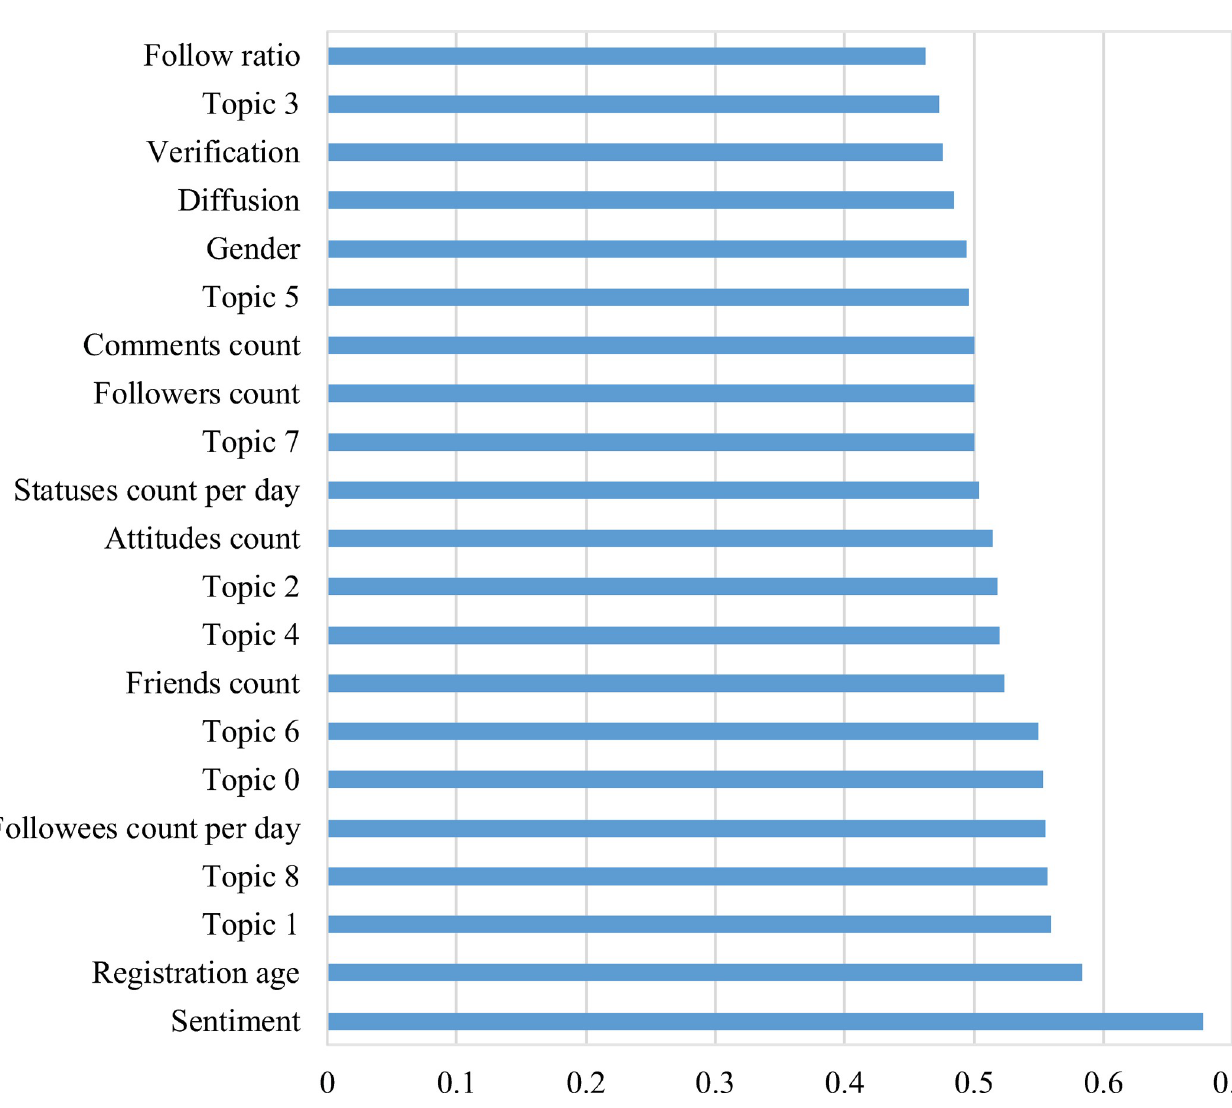
Fig 3. AUC scores of the individual features based on the two-class neural